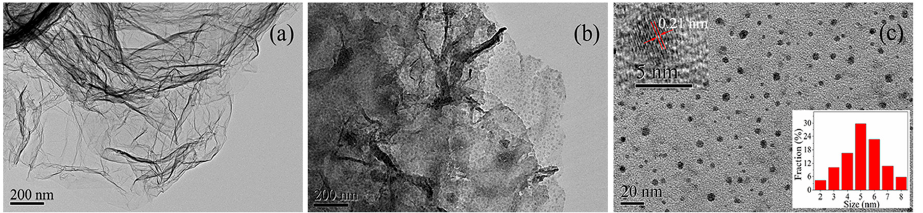
Figure 1. Transmission electron microscope (TEM) images of ( a ) FG; ( b ) the annealed sample fluorinated graphene (FG)-780, which was obtained by annealing FG at 780 K; ( c ) the annealed sample graphene quantum dots (GQDs)-F, which was obtained by annealing FG at 810 K. The upper left inset is HRTEM image, and the lower right inset is the diameter distribution of GQDs-F.